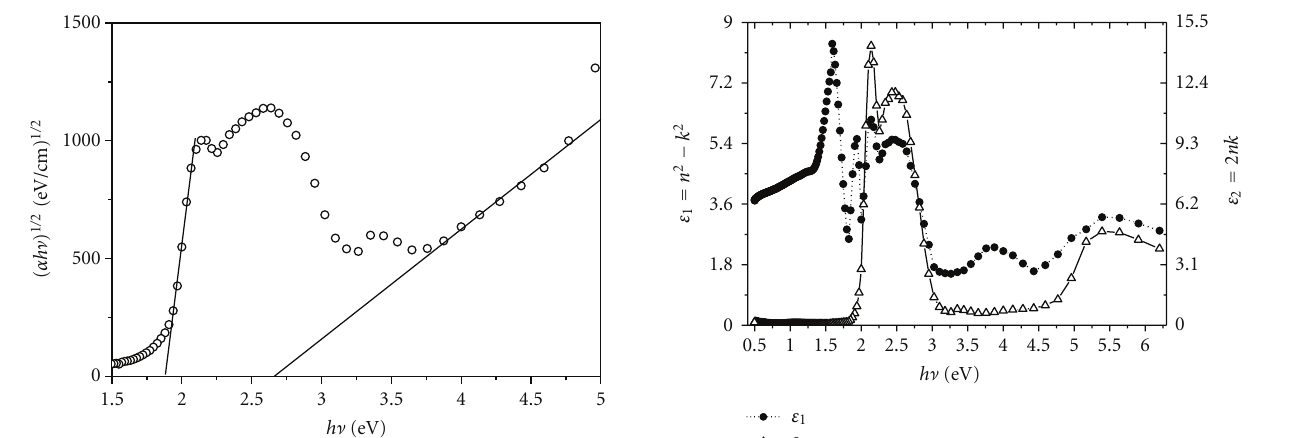
Figure 11: Plot of ε 1 , the real dielectric constant, and ε 2, the imaginary dielectric constant, versus photon energy for PTDCI films, as indicated in the figure.